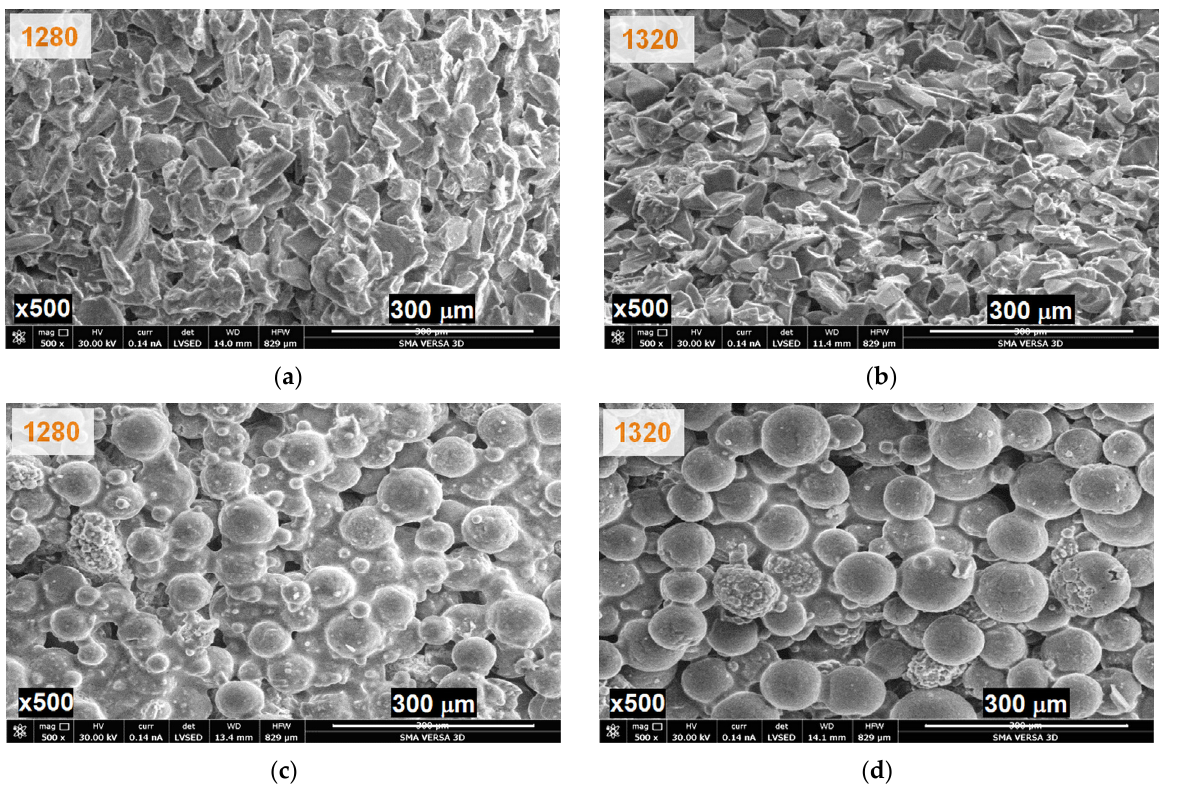
Figure 10. SEM images of fracture surfaces of ceramics based on ( a , c ) electrocorundum F240 and ( b , d ) hollow alumina microspheres prepared with 15 wt.% of bentonite binder by direct casting. The figures indicate the sintering temperature in °C.